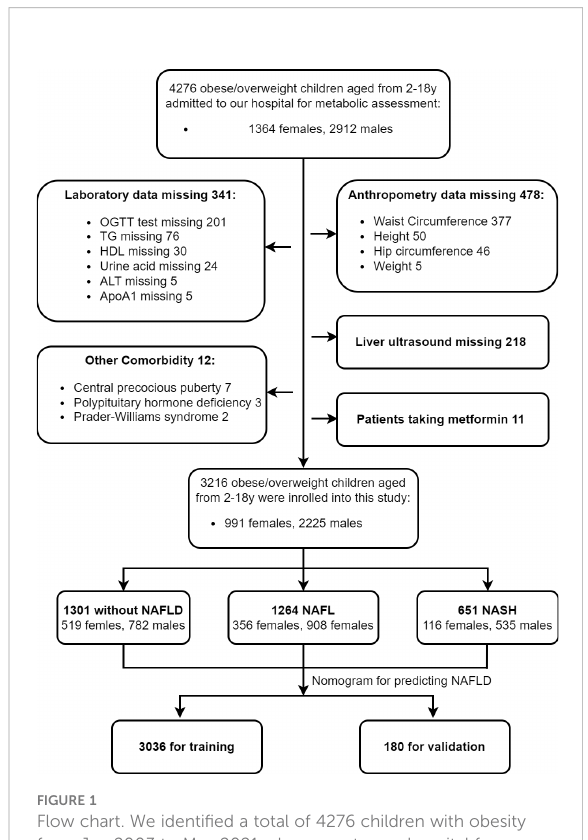
FIGURE 1 Flow chart. We identi fi ed a total of 4276 children with obesity from Jan 2003 to May 2021 who came to our hospital for metabolic assessment. 3216 children were enrolled in this study according to the above exclusion criteria. They were divided into three groups according to liver ultrasound and serum ALT concentration, and their clinical characteristics were detailed and analyzed. We established and validated a nomogram model for predicting childhood NAFLD. Among which, 3036 cases were used as the training set and 180 cases were used as the validation